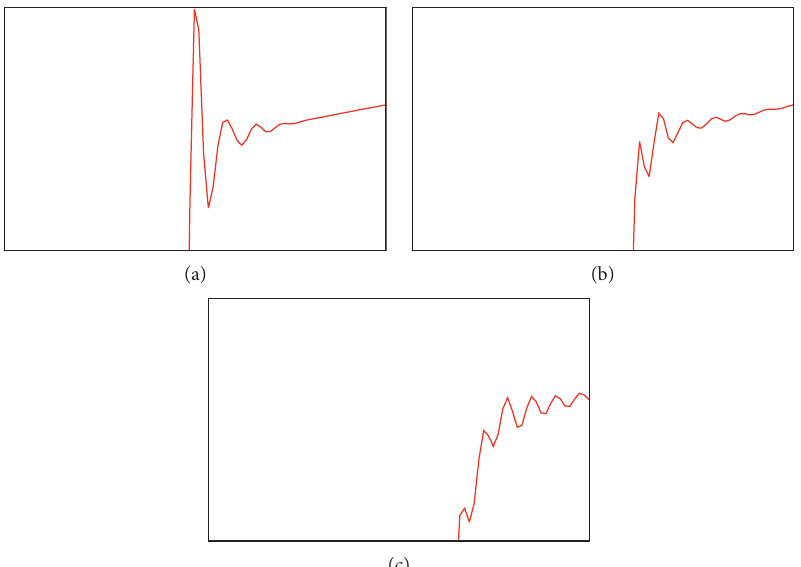
Figure 10: The plot of the peak part of Figures 8(a)–8(c).